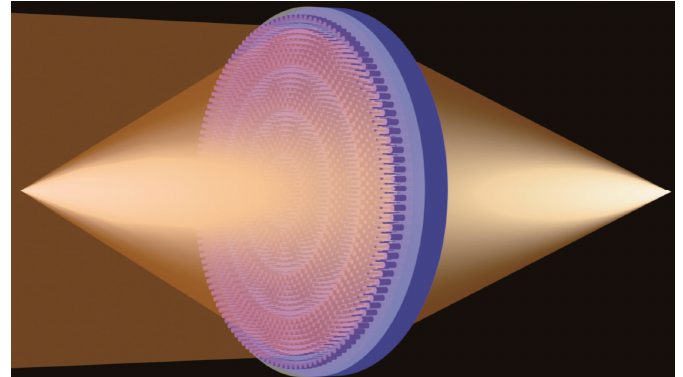
Figure 1. Schematic of duplex focusing of MDL with temperature changes. At room temperature, the metalens achieves transmission focusing ( left ). When the temperature rises to 355 K, VO 2 becomes the metallic phase and causes the metalens reflection to focus ( right ).